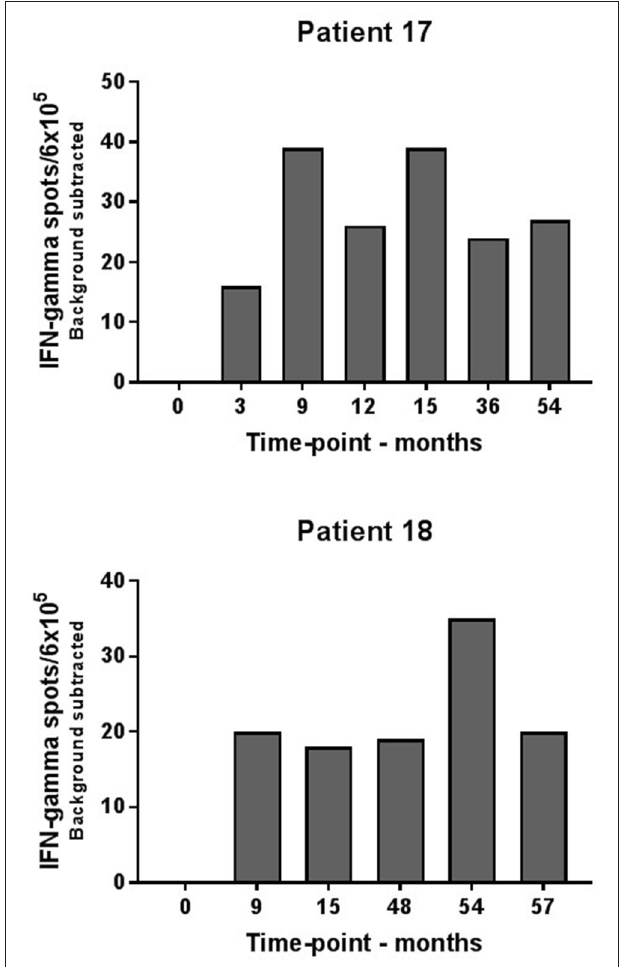
FIGURE 2 | Elispot analysis of IDO-specific T-cells in consecutive blood samples from long-term responders. IDO specific T-cells were demonstrated in patient #17 and #18 at several time points during IDO vaccination